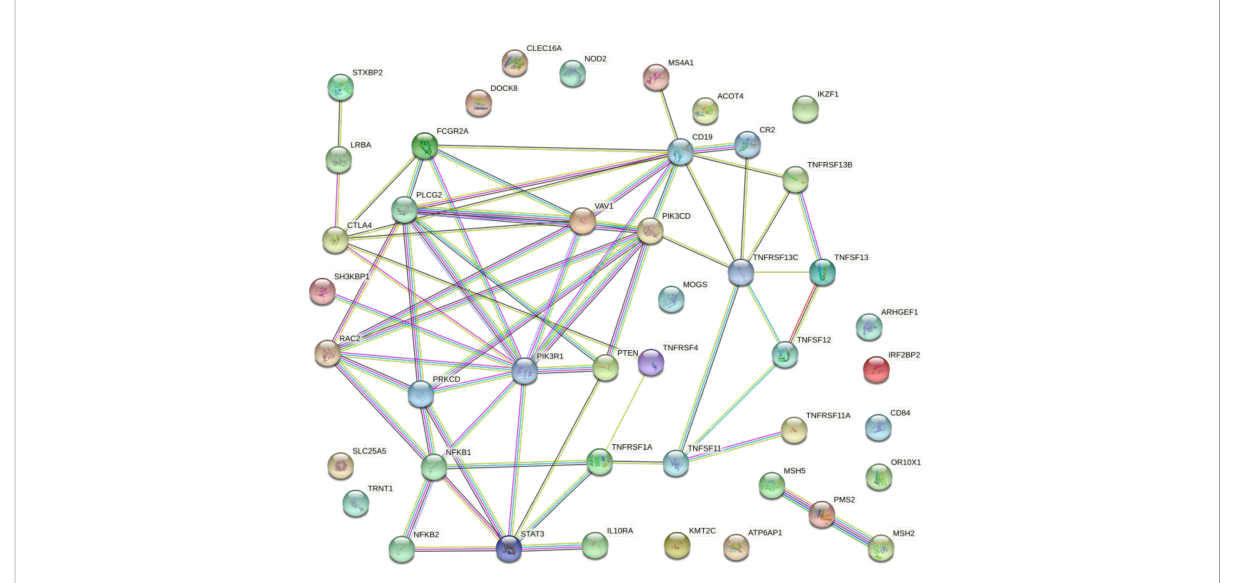
FIGURE 1 Protein – protein interaction map displaying the signi fi cant functional network integrated by the selected genes involved in NHL and CVID. Known interactions are displayed in blue and pink lines. Predictive interactions include the following: green line, gene neighborhood; red line, gene fusions; blue line, gene co-occurrence; yellow line, text mining; black line, co-expression; and gray line, protein homology. Connections are fi ltered by the highest con fi dence (0.7). PPI enrichment p -value: < 1.0e −